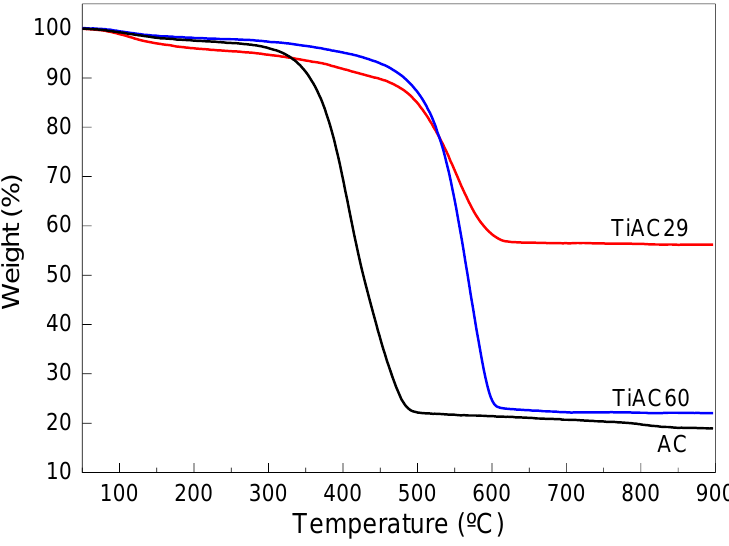
Figure 5. Thermogravimetric curves of bare AC and TiACX composites obtained under air flow.